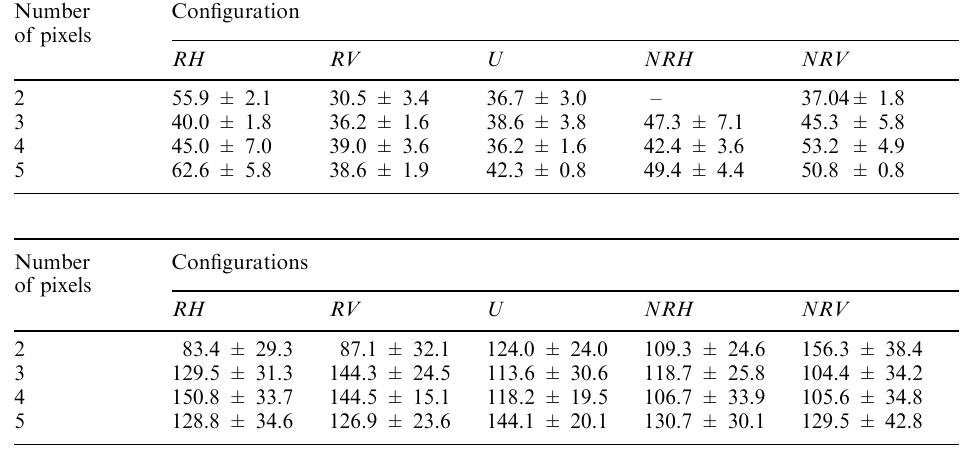
Table 3a. Theoretical average radius R and standard deviation for spherical particles ( (cid:108) m).